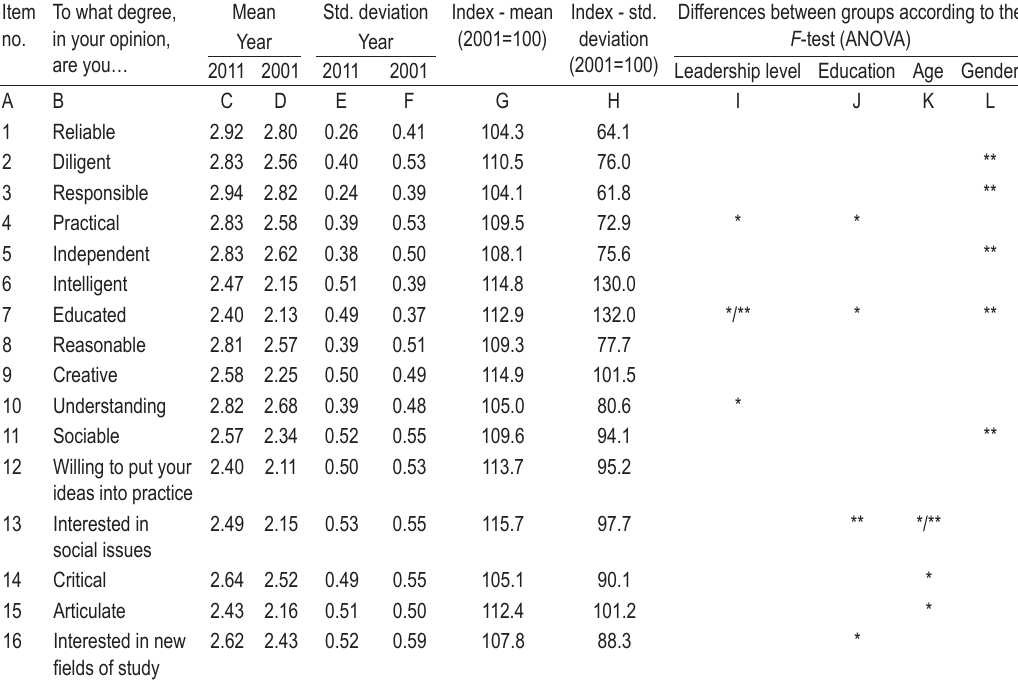
Table 2. Comparison of assessment results between years and groups of nurse leaders Item no.